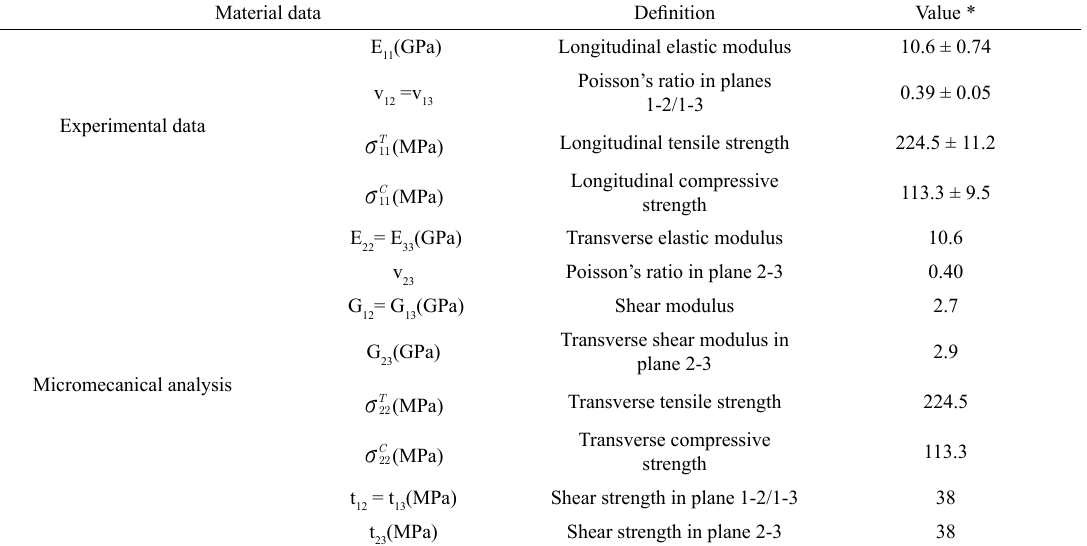
Table 2. Parameters used in numerical simulations of glass fibre/epoxy composite. Material